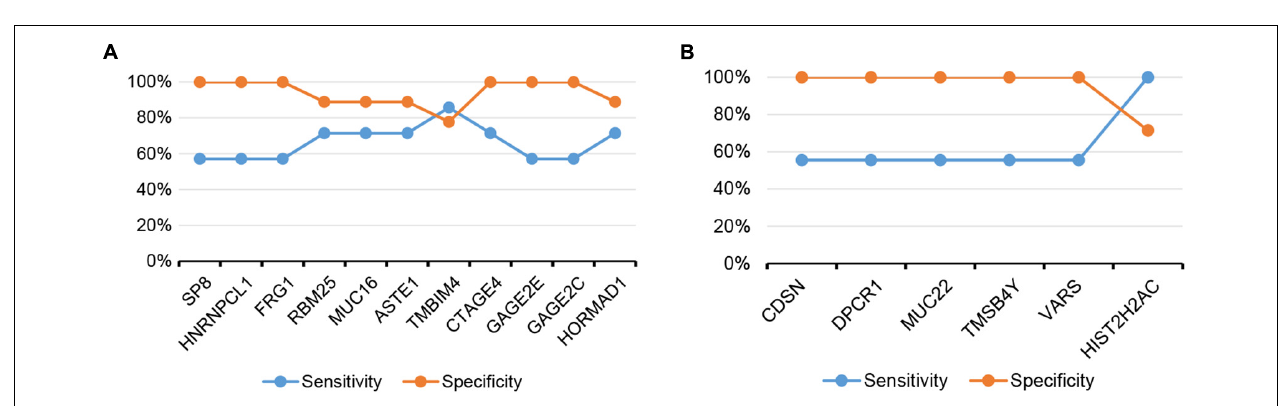
FIGURE 4 | Single-nucleotide and composite mutational signatures in dicycloplatin-sensitive and dicycloplatin-resistant groups. (A) Stacked bar graph of the percentages of six single-nucleotide substitutions in the sensitive (left) and resistance (right) groups. (B) Stacked bar graph of the percentages of COSMIC trinucleotide mutational signatures in the sensitive (left) and resistance (right) groups. The types of substitutions are color coded.